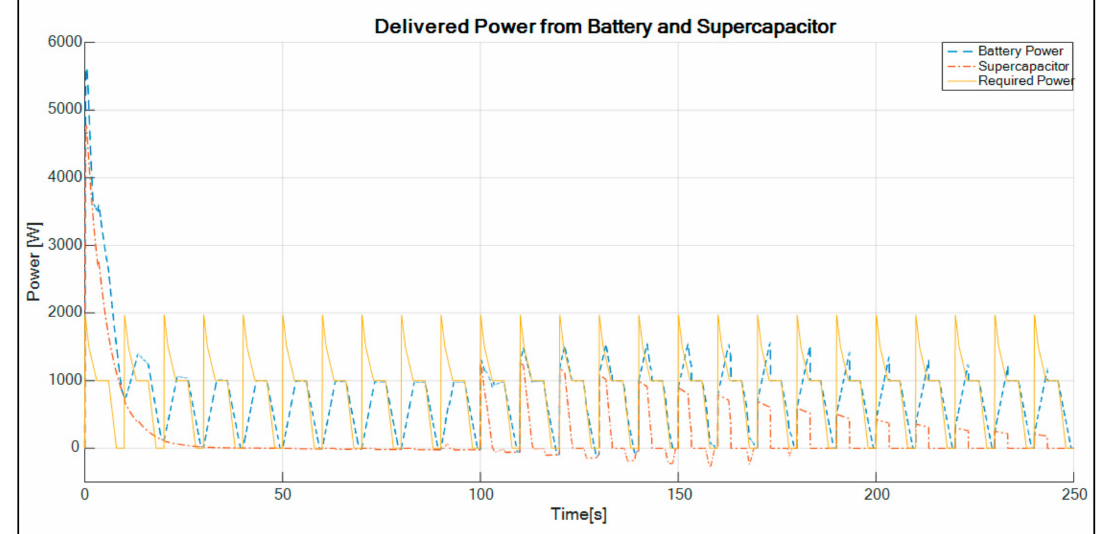
Figure 11. Typical power delivered by the LAB/supercapacitor hybrid system versus the required power of the hybrid transport vehicle.